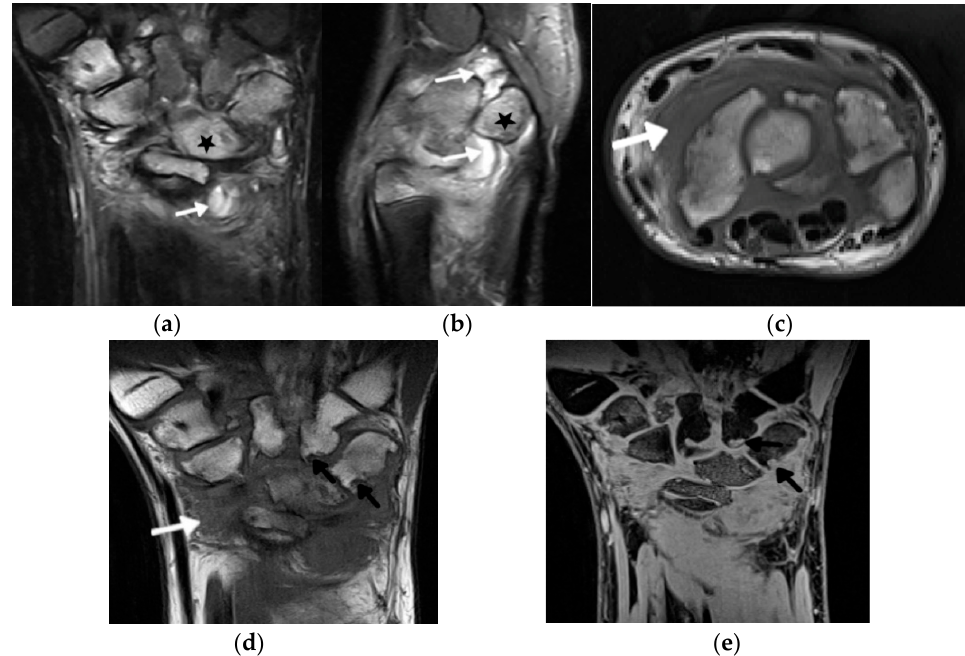
Figure 3. A 14-year-old boy with JIA and wrist arthritis. Coronal T2 Turbo inversion recovery magnitude (TIRM) ( a ), sagittal proton density fat saturated ( b ) and axial T1-weighted time spin echo (TSE) ( c ) MR images show synovitis (white arrows) and bone marrow edema (stars); coronal T1 TSE ( d ) and T1 volume-interpolated breath-hold examination (VIBE) ( e ) show numerous cyst-like changes and erosions (black